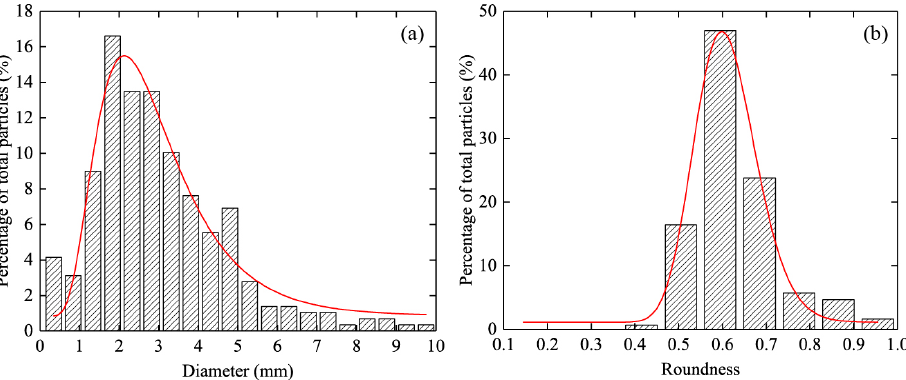
Figure 7. Distribution of the characteristic parameters of granular frazil particles: ( a ) diameter distribution; ( b ) roundness distribution.